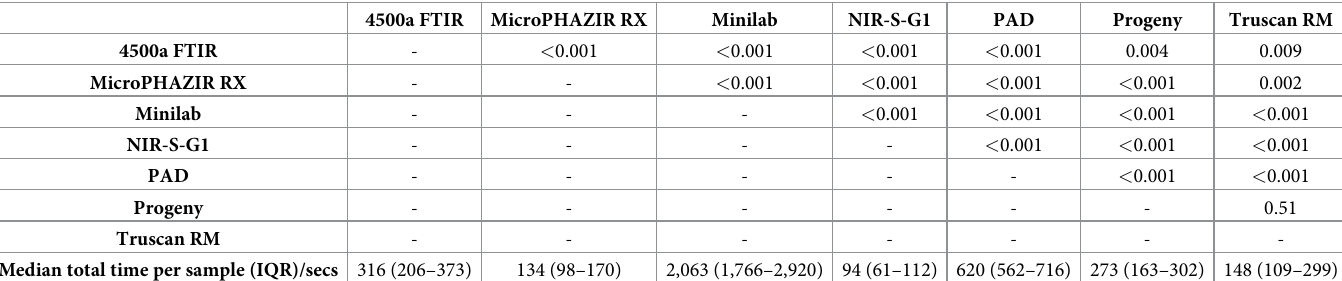
Table 3. Pairwise comparisons of the median total time taken per sample in sample set